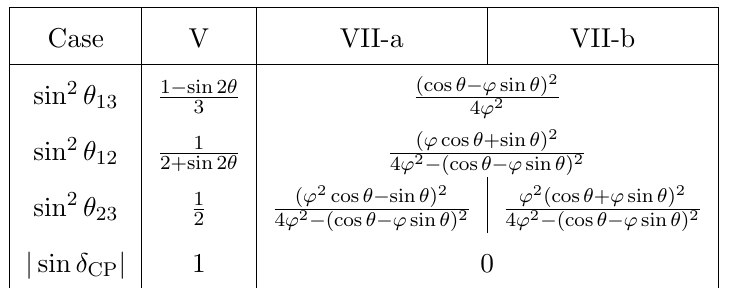
Table 3 . Predictions for the leptonic mixing parameters in terms of the free parameter (cid:18) in Case V (VII) originating from G CP = A 5 o CP broken to G e = Z 3 ( Z 2 in ref. [31]. The quantity ’ = (1 + p 5) = 2 is the golden ratio.